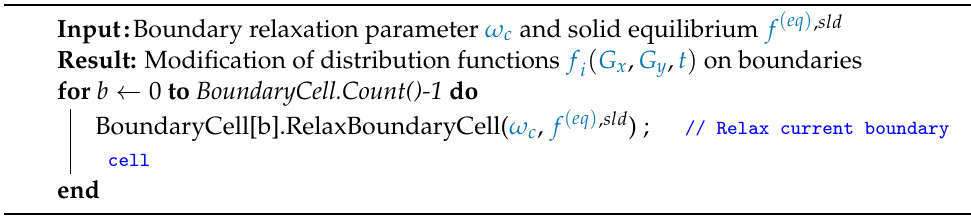
Algorithm 4: Boundary Conditions’